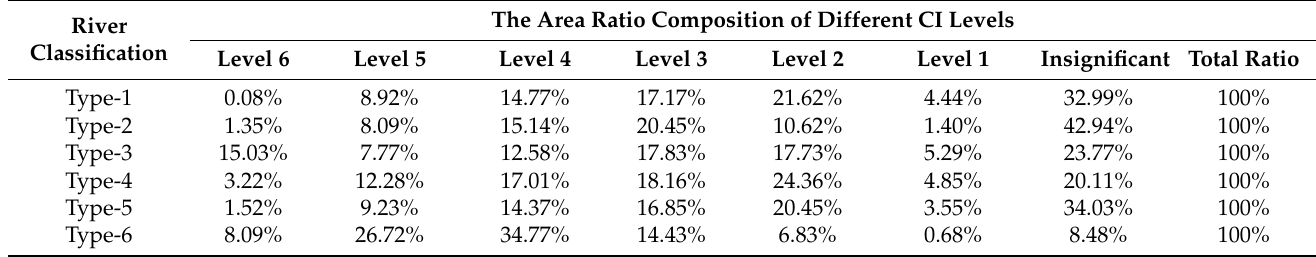
Table 10. The greenspace area proportions of different CI levels in the six river-type